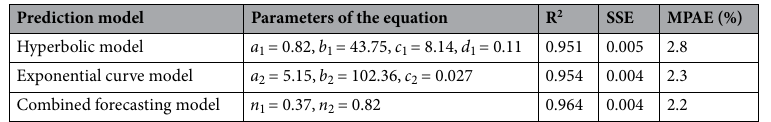
Table 8. Cumulative differential settlement prediction model of monitoring point